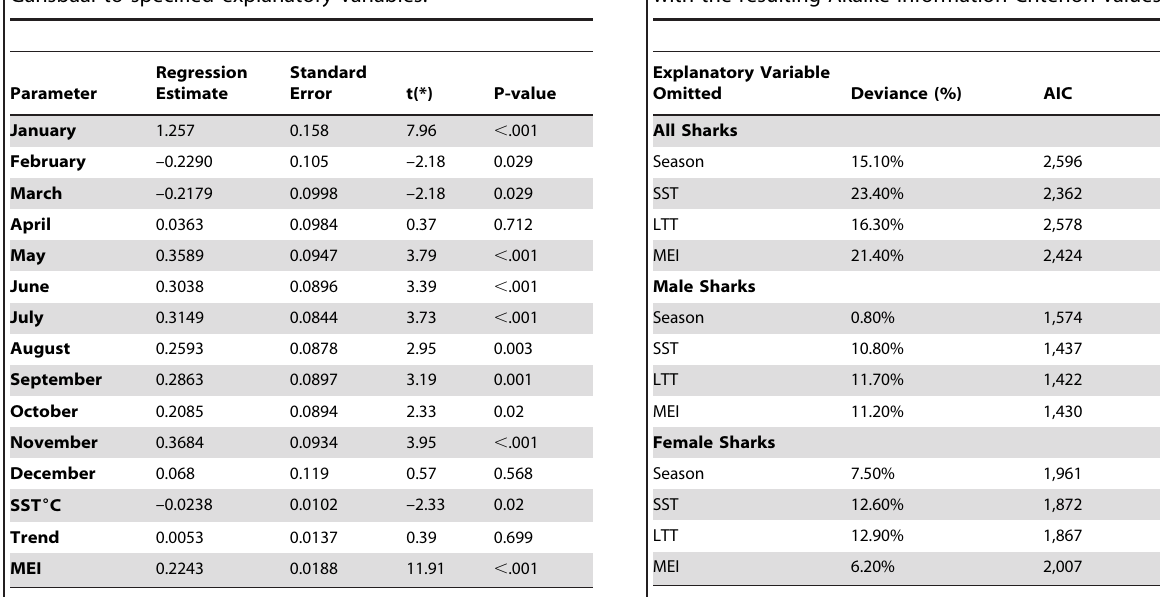
Table 6. Results of a generalized linear model relating total number of female great white sharks observed per trip in Gansbaai to specified explanatory variables.